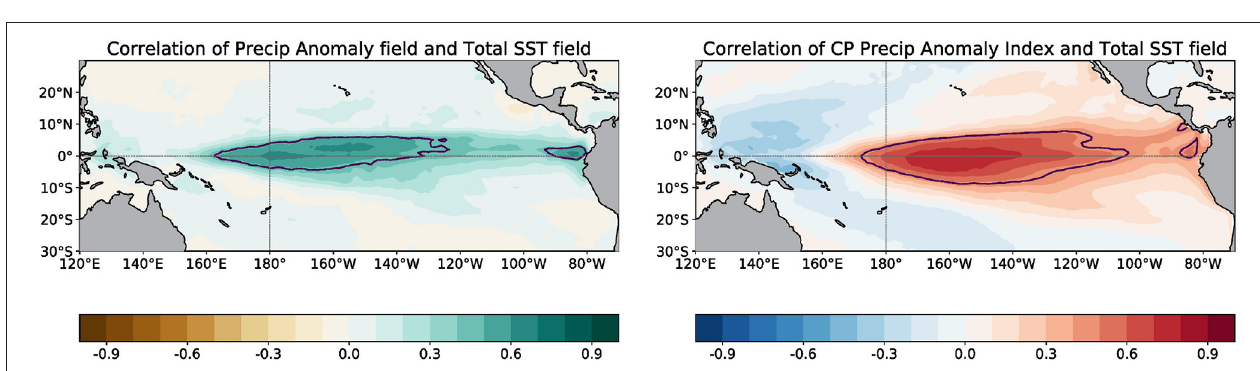
FIGURE 6 | (Left) At each grid point, the correlation between total sea surface temperature and precipitation anomalies. (Right) The correlation between the Central Pacific precipitation anomaly index and total sea surface temperature at each grid point. The black contour shows the 95% level of significance using the effective degrees of freedom as estimated in Bretherton et al.